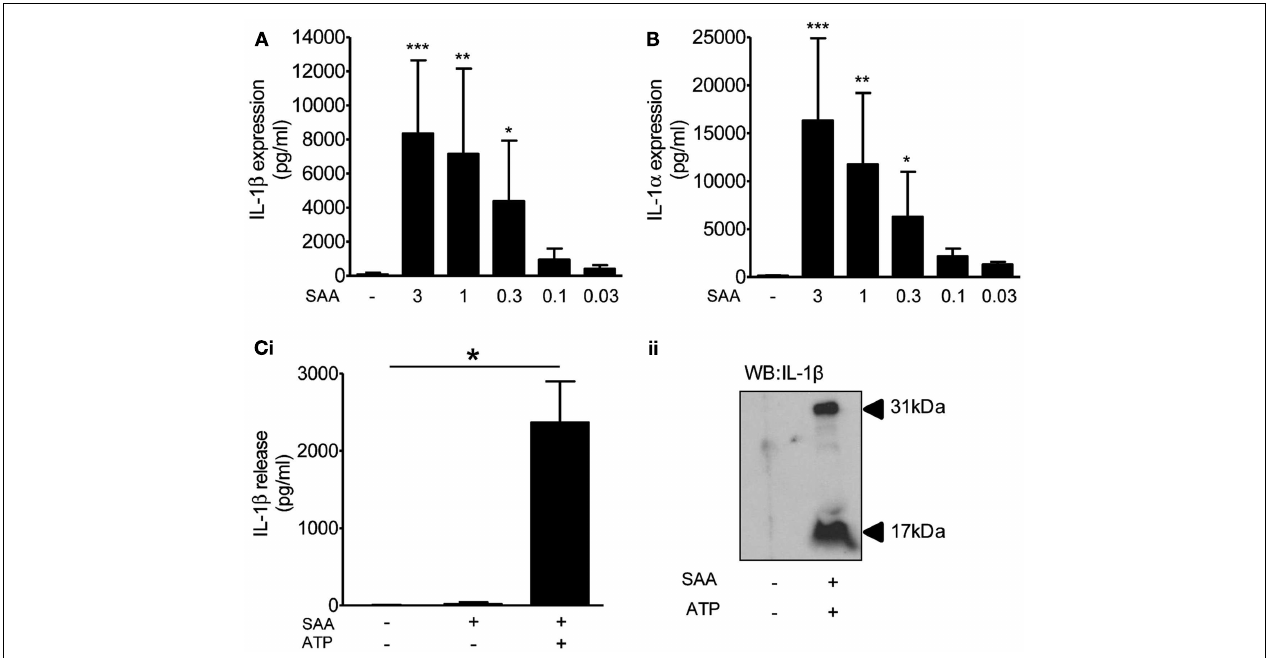
after a 24h priming stimulus with SAA (3 µ g/ml) and released IL-1 β was quantified by ELISA (Ci) . And processing of pro- (31kDa) to mature (17kDa) IL-1 β was analyzed byWestern blot (Cii) . Data are pooled samples from at least five separate experiments. *** P < 0.001, ** P < 0.01, * P < 0.05 vs.